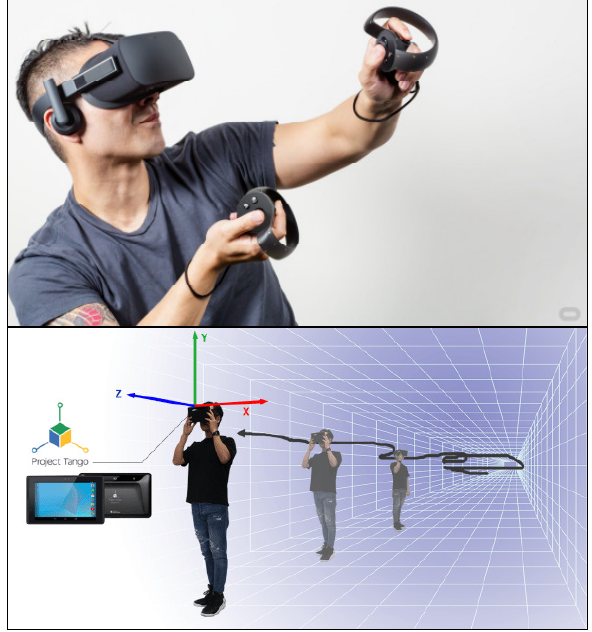
Figure 2. New virtual reality systems applied by and motion tracks, Oculus Rift headset and Project Tango